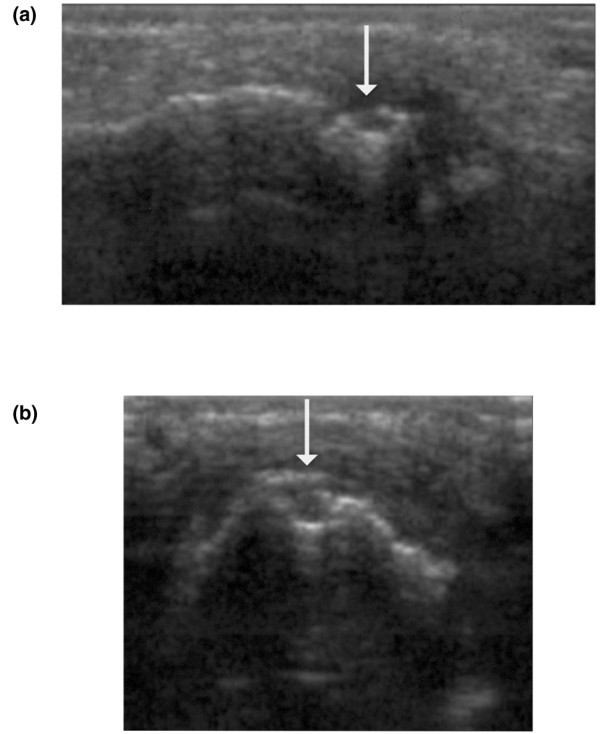
Signs of destruction on ultrasonography in the fourth proximal interphalangeal joint: early RA. MRI and conventional radiography revealed no signs of destruction in the joint. A bone erosion (arrow) is visualized with ultrasonography in (a) the longitudinal and (b) the transverse planes. MRI, magnetic resonance imaging; RA, rheumatoid arthritis.